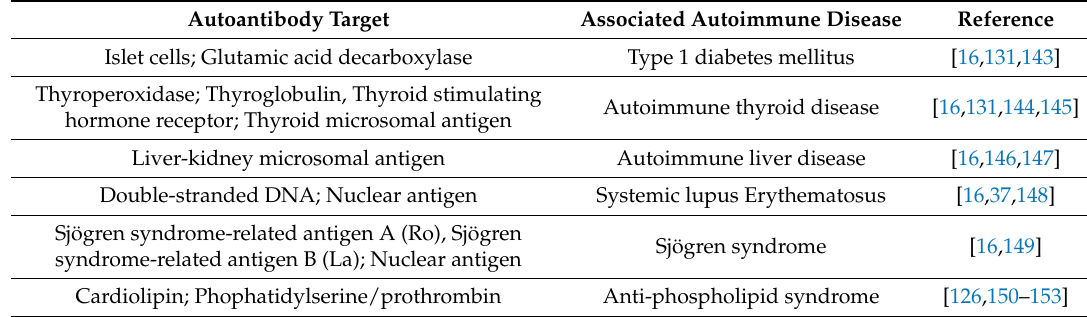
Table 1. Autoantibody reactivities associated with other autoimmune diseases found in patients with celiac